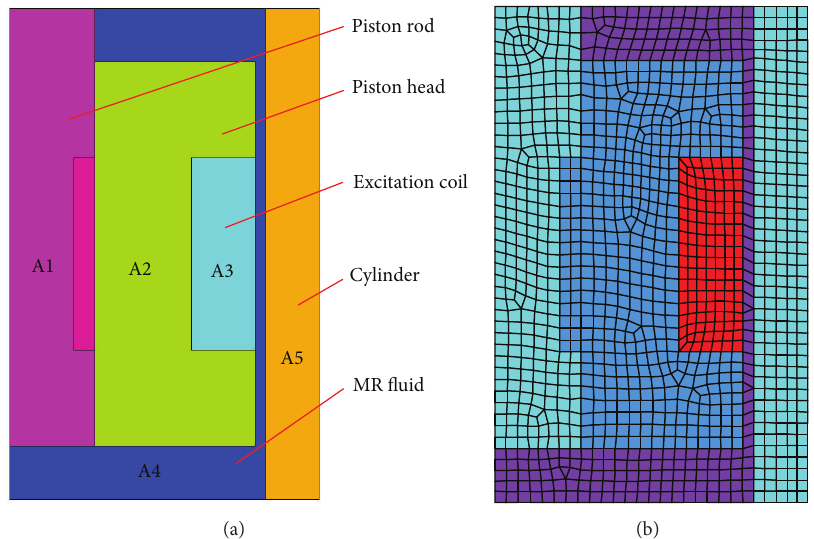
Figure 3: Modelling of the MR damper part: (a) entity model and (b) finite element model.